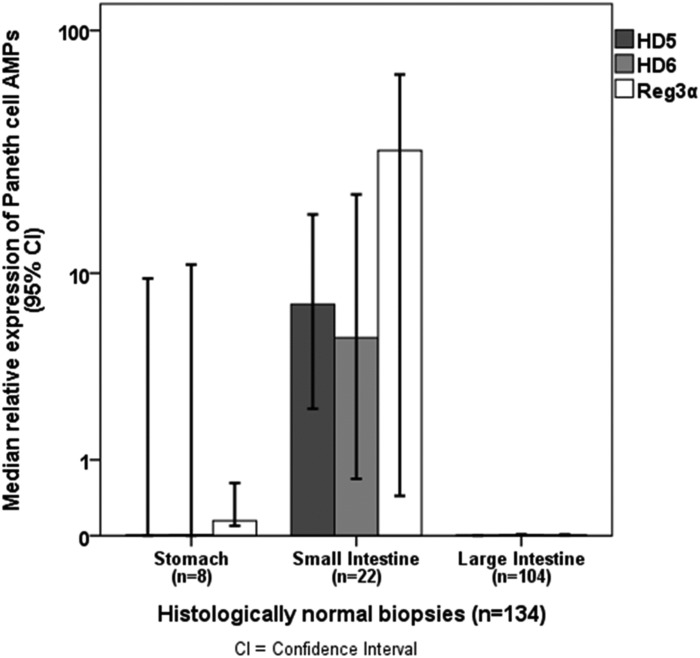
Distribution of Paneth cell AMP expression in relation to the location of biopsy harvesting in the gastrointestinal tract.The relative expression of the Paneth cell AMPs HD5, HD6 and Reg3α was higher in the small intestine (n = 22) than in the stomach (n = 8) and large intestine (n = 104) in histologically normal biopsies (n = 134, p<0.02, Mann-Whitney-U-Test).